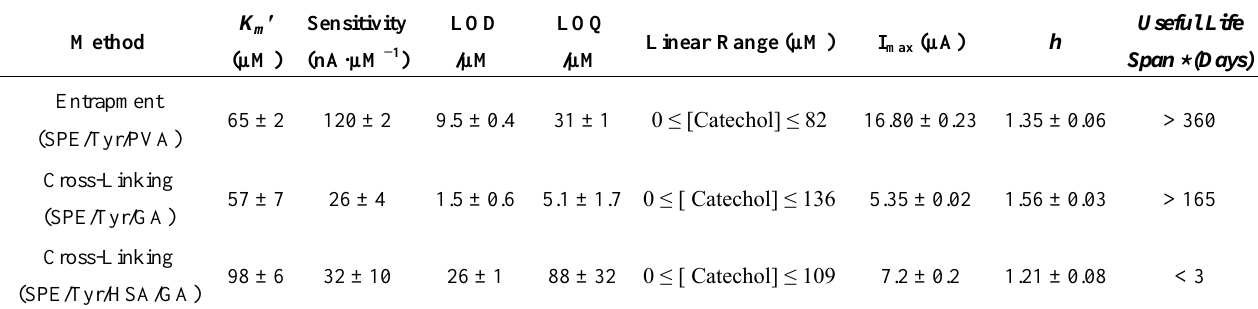
Table 1. Analytic parameters of the tyrosinase immobilized through entrapment, cross-linking and covalent bonding over screen-printed-type